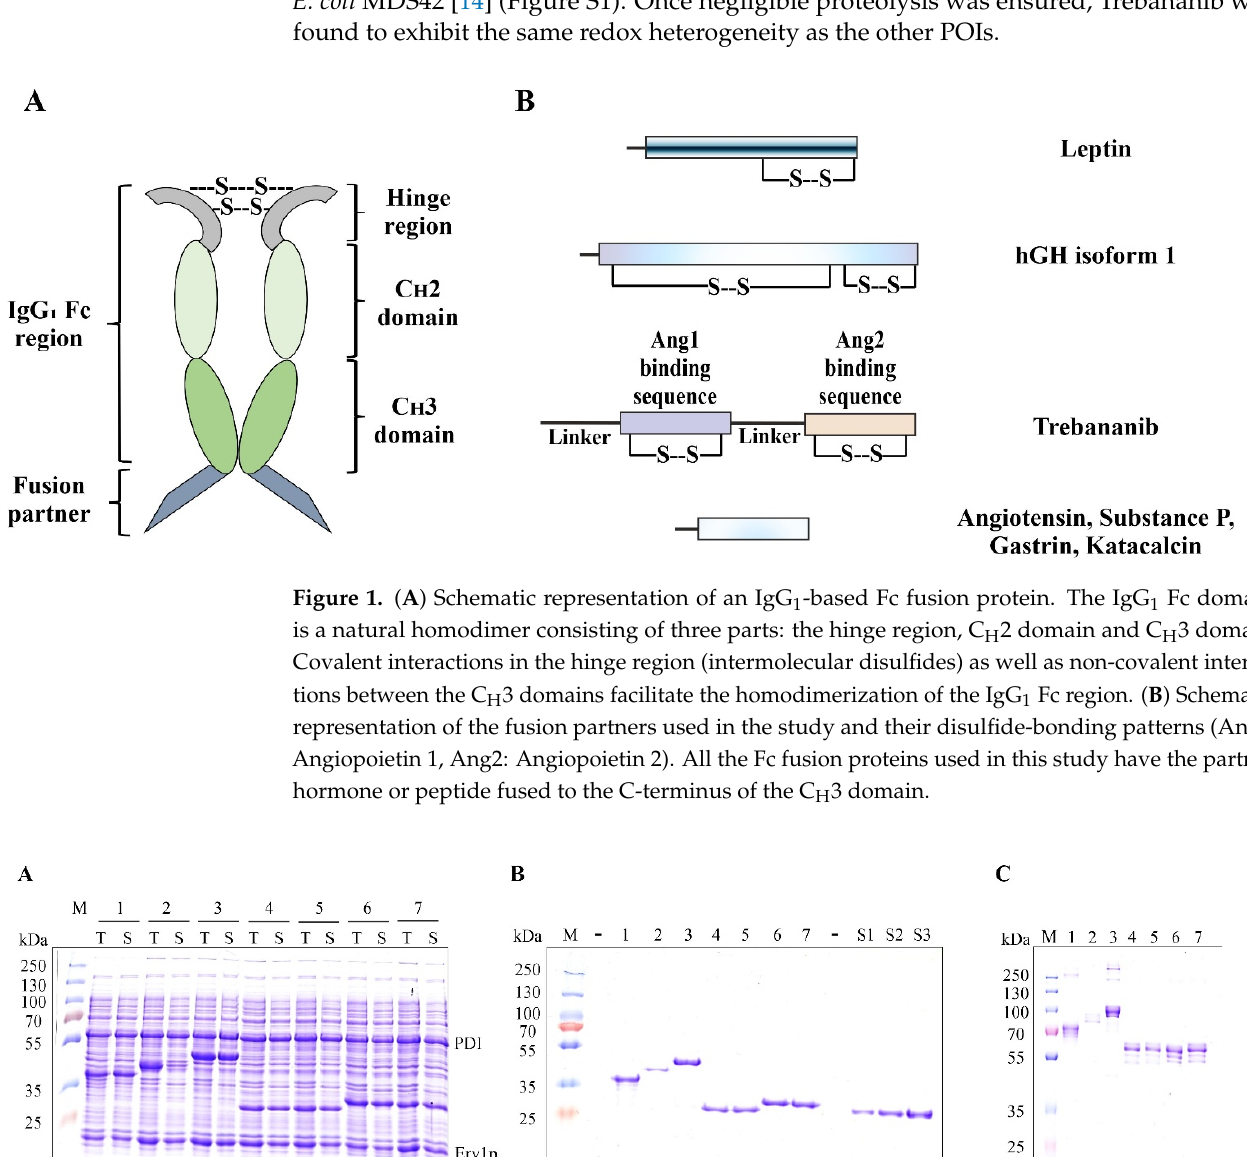
Figure 2. SDS ‐ PAGE analysis of seven candidate Fc fusion proteins produced solubly with the help of the CyDisCo system in the cytoplasm of E. coli ( A ) SDS ‐ PAGE gel image of T: total cell lysate and S: soluble cell lysate under reducing conditions. ( B ) SDS ‐ PAGE gel image of Protein G ‐ based puri ‐ fied POIs and purified wild type IgG 1 Fc region in three different concentrations under reducing conditions. ( C ) SDS ‐ PAGE gel image of Protein G ‐ based purified POIs under non ‐ reducing and N ‐ Ethyl maleimide (NEM) ‐ treated conditions showing redox heterogeneity. M: marker, 1: Trebananib, 2: Leptin–Fc, 3: hGH–Fc, 4: Angiotensin–Fc, 5: Substance P–Fc, 6: Gastrin–Fc, 7: Katacalcin–Fc, S1: IgG 1 Fc region (0.19 μ g), S2: IgG 1 Fc region (0.38 μ g), S3: IgG 1 Fc region (0.56 μ g).